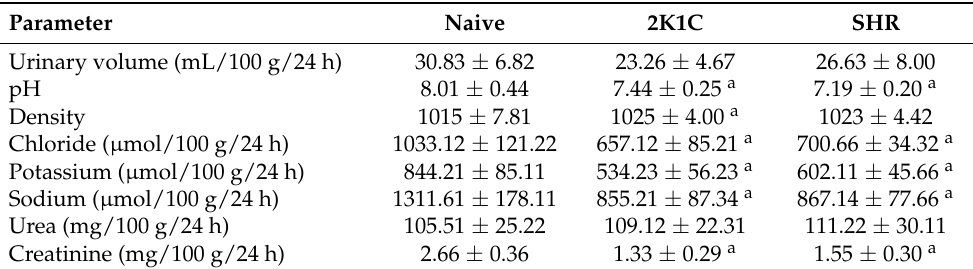
Table 1. Urinary parameters of the different experimental groups at the end of 6 weeks of treatment with the high-fat